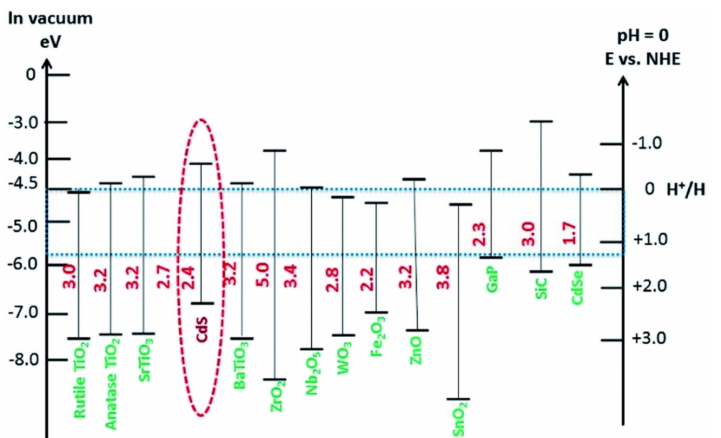
Figure 13. Schematic diagram of energy level positions for CdS and other semiconductors rela- tive to the redox potential of water. Reproduced with permission from [273]. Royal Society of Chemistry,